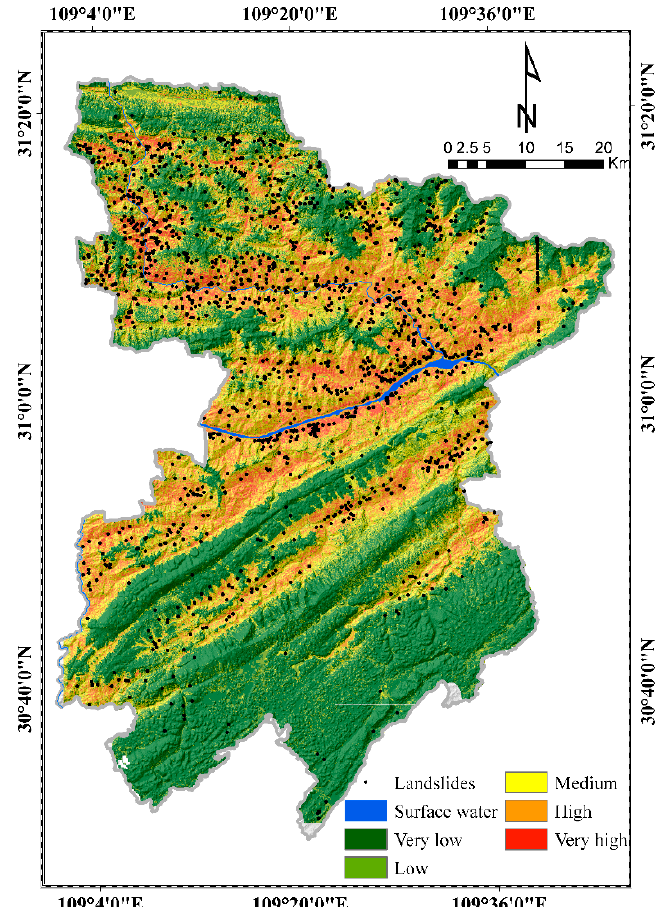
Figure 12. Landslide comprehensive susceptibility map.